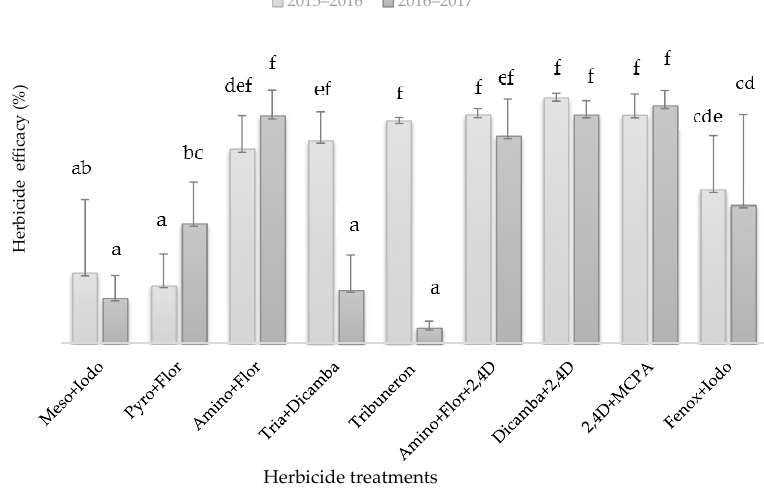
Figure 2. Efficacies of different herbicide treatments on G. coronaria dry weight reduction assessed in a field trial in two consecutive seasons (2015–2016 and 2016–2017). Different letters denote significantly differences between herbicides within a year according to the Duncan test ( p = 0.05). Herbicide abbreviations; Meso + Iodo: mesosulfuron + iodosulfuron; Pyro + Flor: pyroxsulam + florasulam, Amino + Flor: aminopyralid + florasulam; Tria + Dicamba: triasulfuron + dicamba; Tribenuron: tribenuron − methyl; Amino + Flor + 2,4D: aminopyralid + florasulam + 2,4 D EHE ehe; Dicamba + 2,4D: dicamba + 2,4 D; Fenox + Iodo: fenoxaprop-p-ethyl + iodosulfuron.